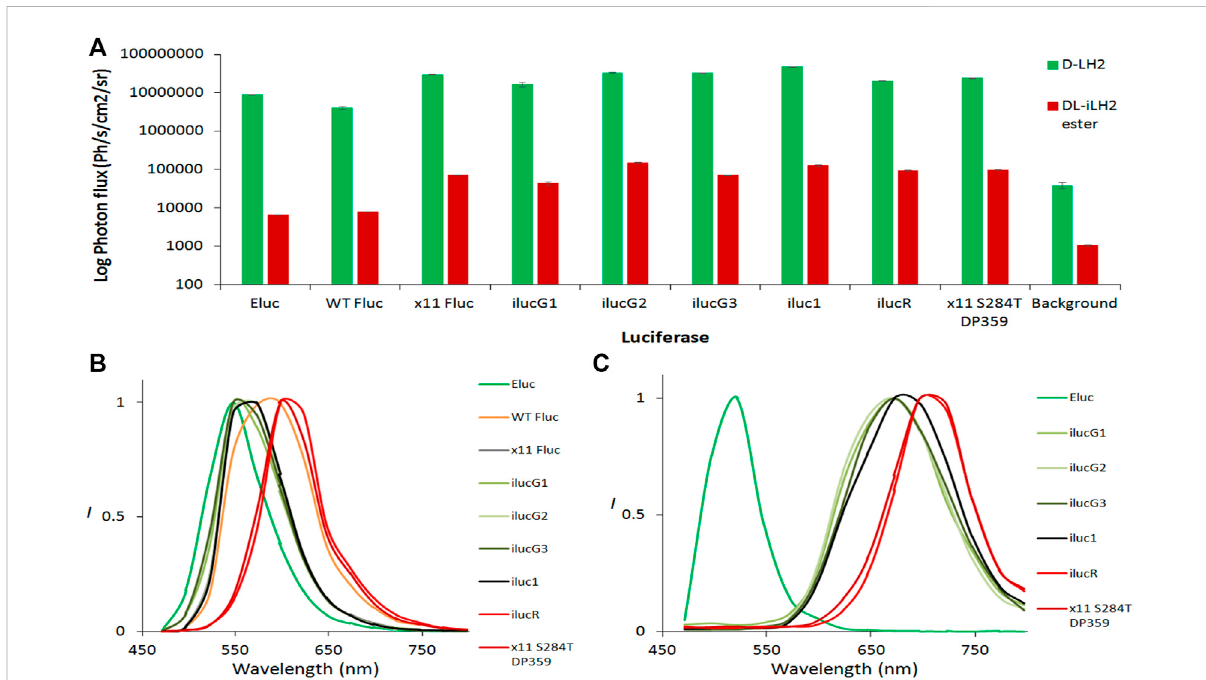
FIGURE 6 Bioluminescence yields and spectra from transfected HEK 293 cells. (A) EGFP normalized light yields from whole HEK cells. 1mM D -LH 2 K + salt or DL -iLH 2 Me ester was added to initiate luminescence, and emission was captured over 5 min at 30 ° C in the PIO (Biospace Labs, Paris, France). Emission with both substrates was observed to take approximately 1 min to reach a plateau, and light yields given were from 1 min after addition of substrates. Background signals were obtained from triplicate ROIs placed in areas of images containing no wells. (B) Normalized bioluminescencespectraobtainedfromwholetransfectedHEKcellsexpressingdifferentvariantswith (B) D -LH 2 and (C) DL -iLH 2 Meesterimagedin the PIO.